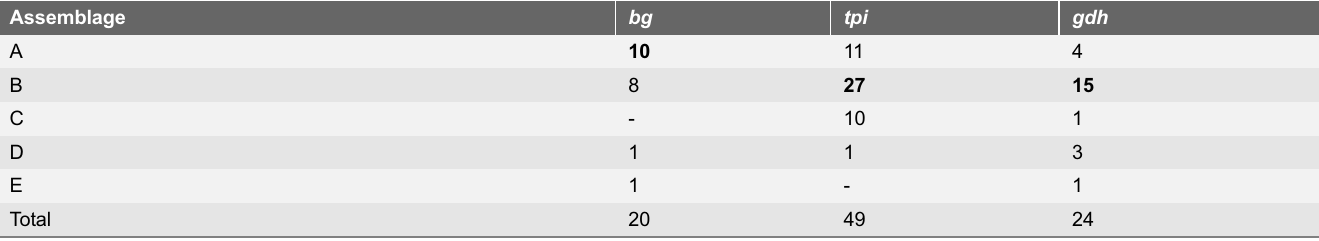
Table 3. Distribution of different haplotypes from each genetic assemblage within each gene.